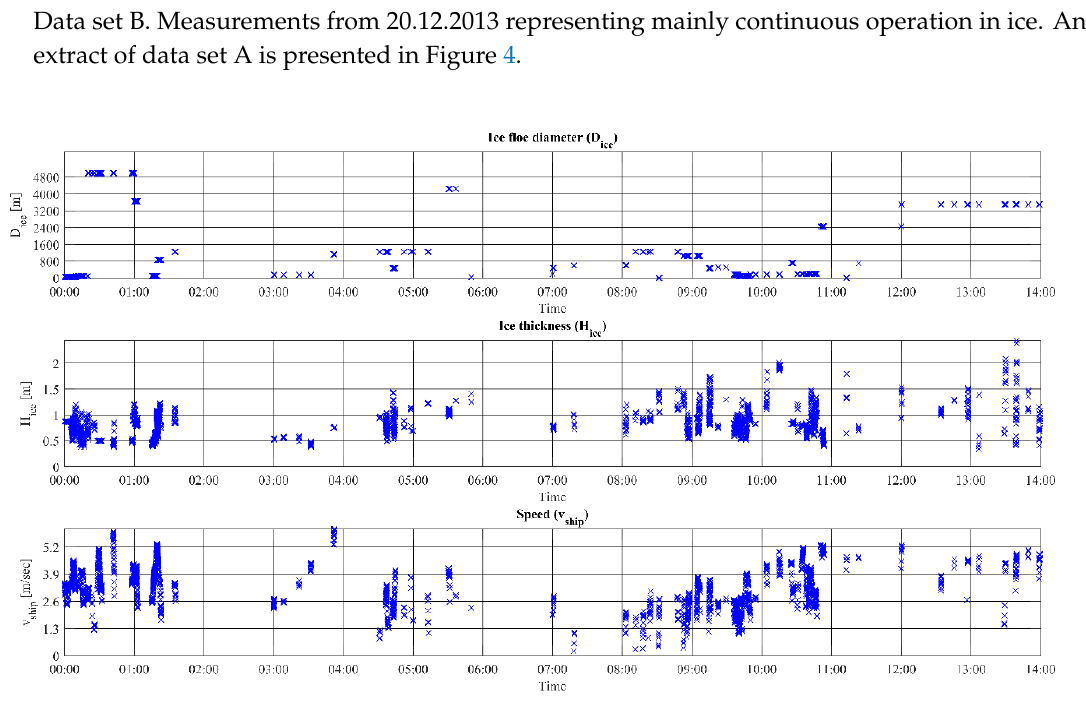
Figure 2. Location of strain gauges on the S.A. Agulhas II. (The figure was determined based on Suominen & Kujala [40]).